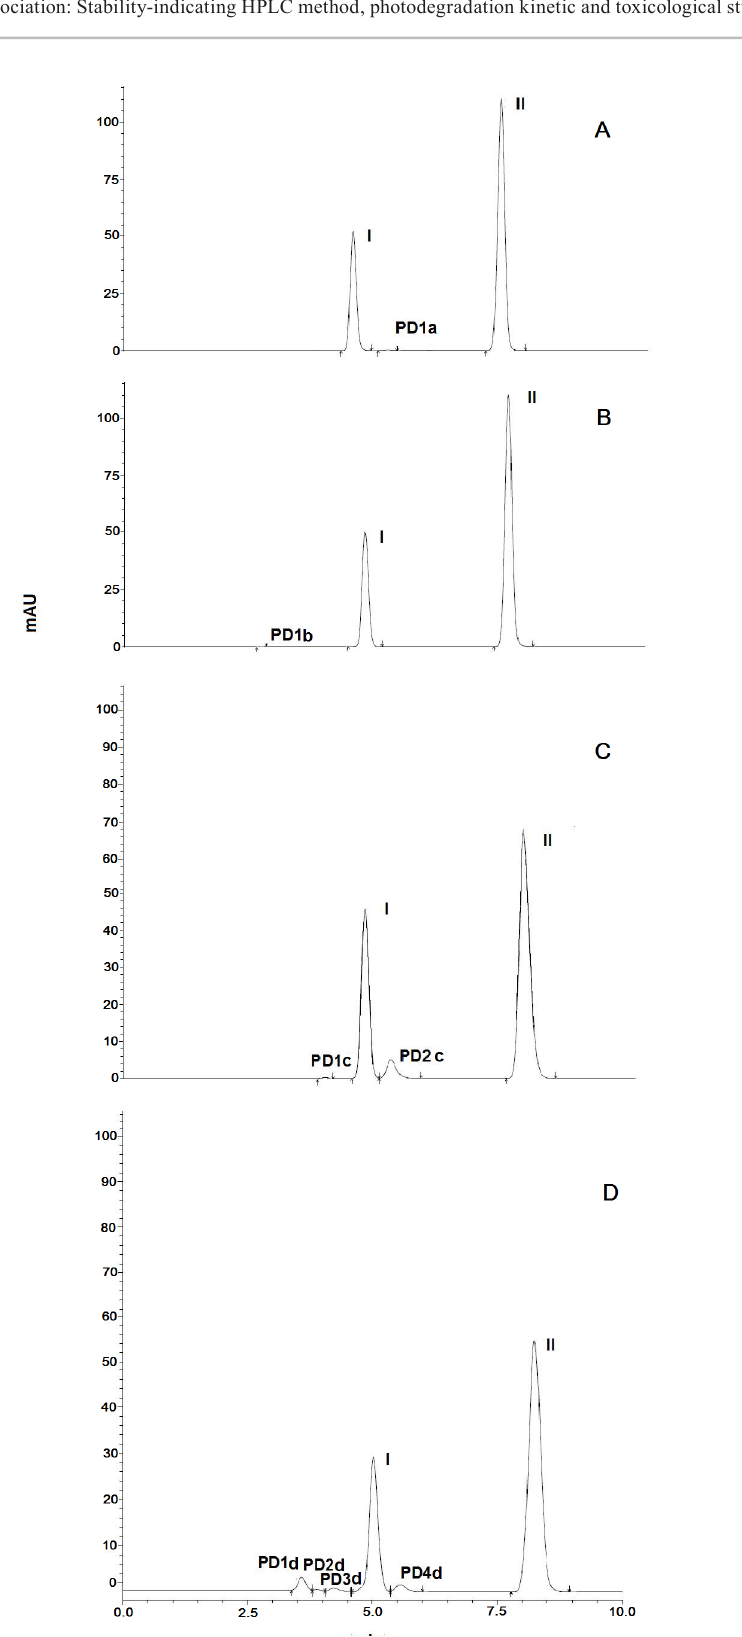
FIGURE 3 - Chromatograms obtained for forced degradation of TAD (I) and SIL (II). A : acidic degradation; B : alkaline degradation; C : oxidative degradation; D : photolytic degradation; PD : likely degradation